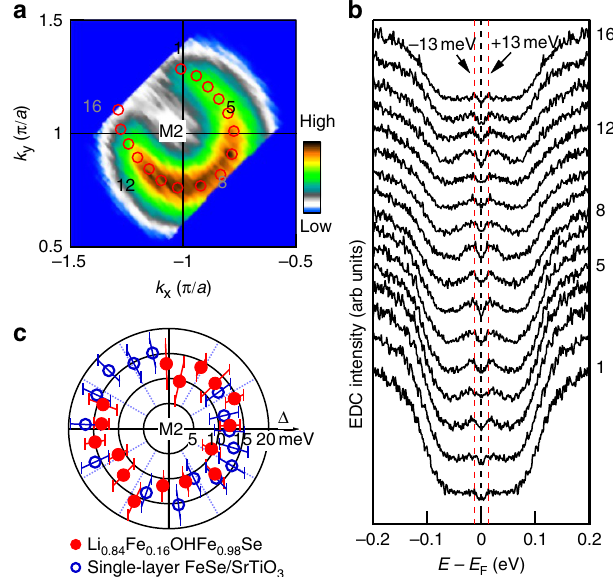
Figure 4 | Momentum dependence of the superconducting gap of (Li 0.84 Fe 0.16 )OHFe 0.98 Se superconductor. ( a ) Fermi surface mapping near M2 point. The corresponding Fermi crossings are marked by red empty circles with numbers from 1 to 16 (for clarity, the intermittent points are not labelled). ( b ) Symmetrized EDCs measured at 20K from Fermi crossing 1 to 16 along the measured electron-like Fermi surface around M2. The red dashed lines represent the energy positions of ± 13meV with respect to the Fermi level. ( c ) Momentum dependence of the superconducting gap (red solid circles) along the Fermi surface around M2 for (Li 0.84 Fe 0.16 ) OHFe 0.98 Se superconductor. For comparison, the gap along the electron- like Fermi surface around M2 of the superconducting single-layer FeSe film is also plotted (blue empty circles) 20 . The error bars are defined as